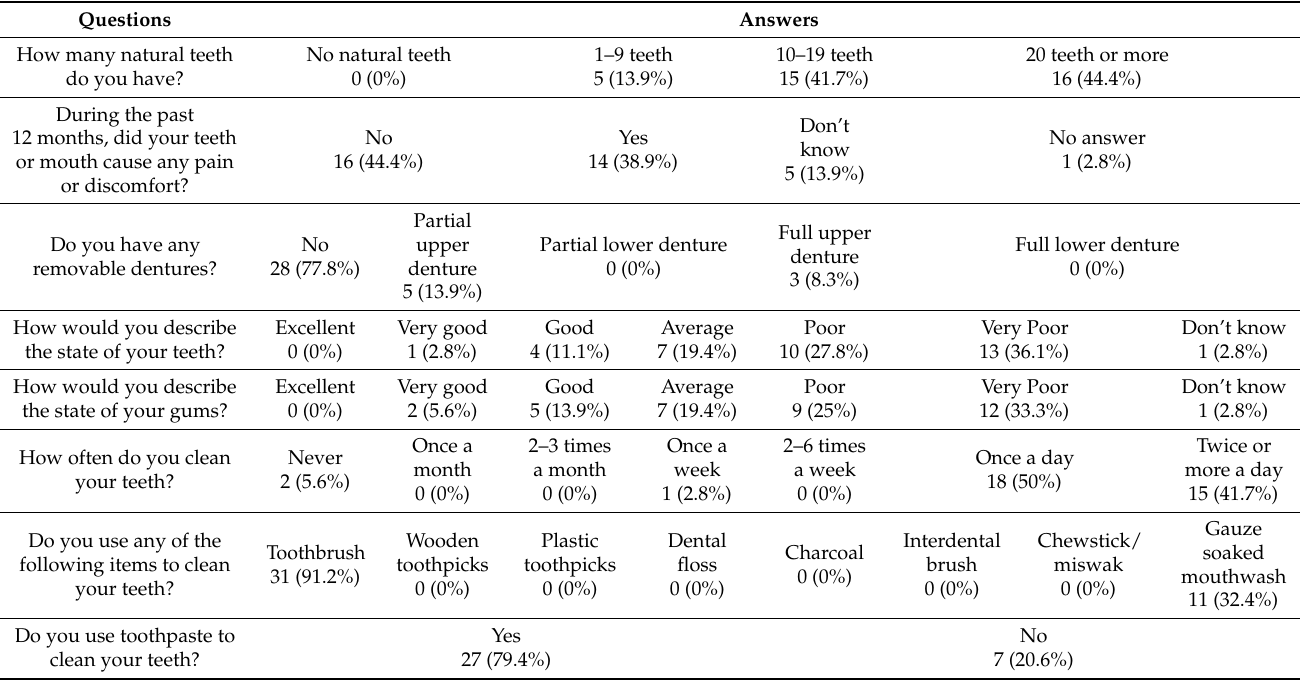
Table 2. Oral health